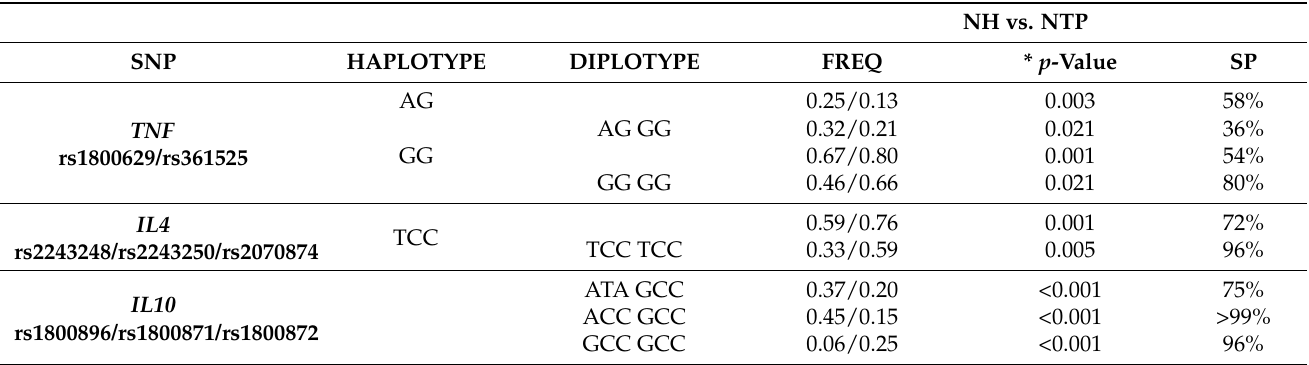
Table 7. Haplotype and diplotype distribution frequencies of TNF , IL4, and IL10 genes in NSAID hypersensitivity compared to NSAID-tolerant